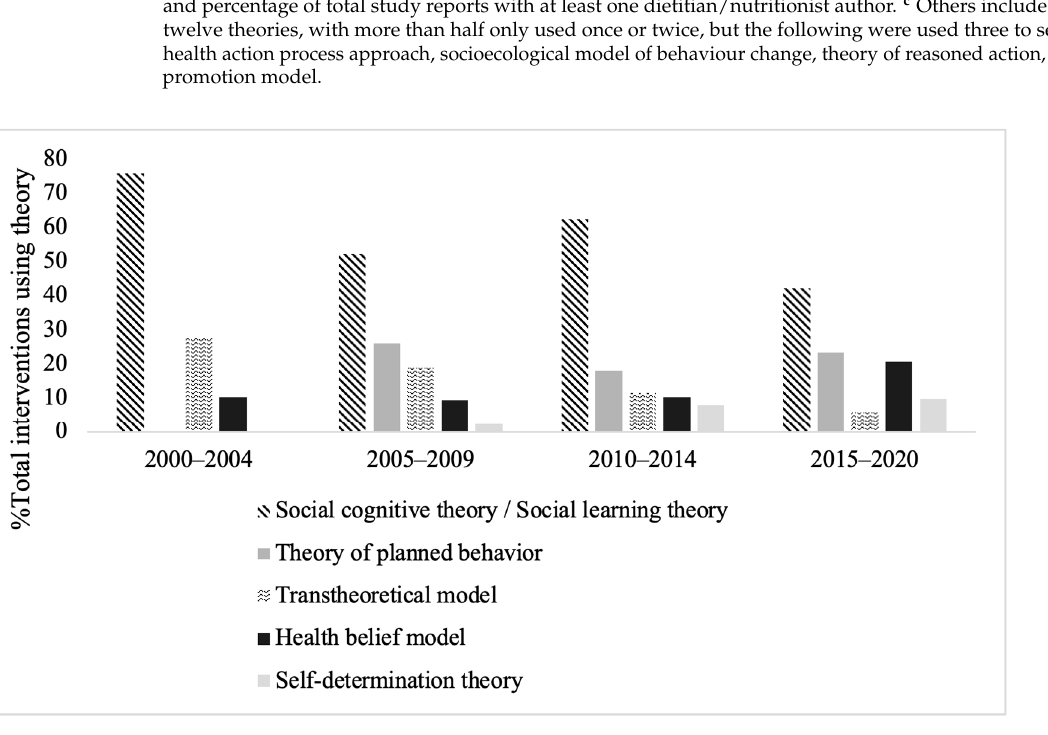
Figure 3. The percentage of total interventions using the top five most used behaviour change theories in five-year inter- vals.